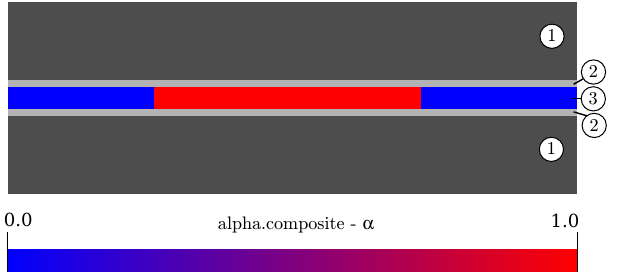
Figure 3. Multi-region and multi-phase domains. The heating/cooling plates (1) and the tools (2). The fluid domain (3) is treated as a multi-phase region that includes a composite part (red) and air